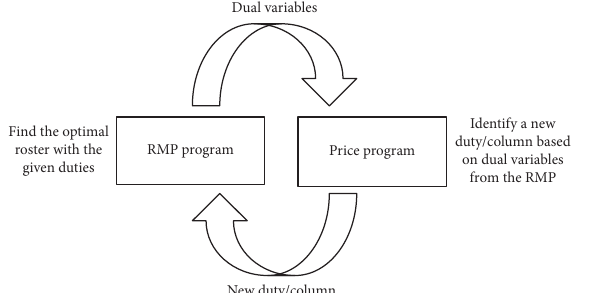
Figure 3: The decomposition scheme of the proposed BPC algorithm.